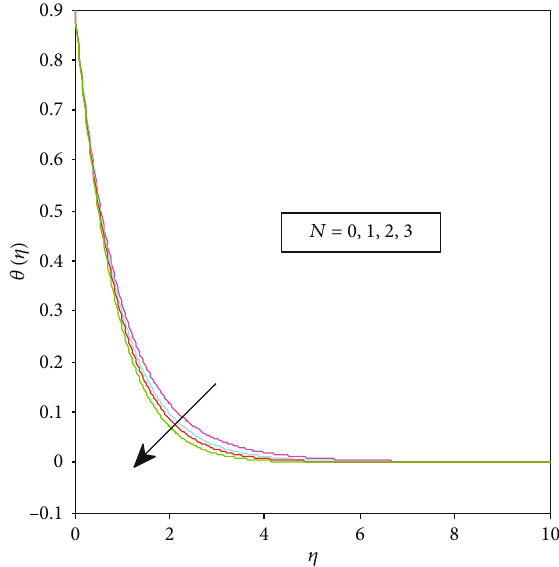
Figure 13: Temperature distribution for di ff erent values of N .